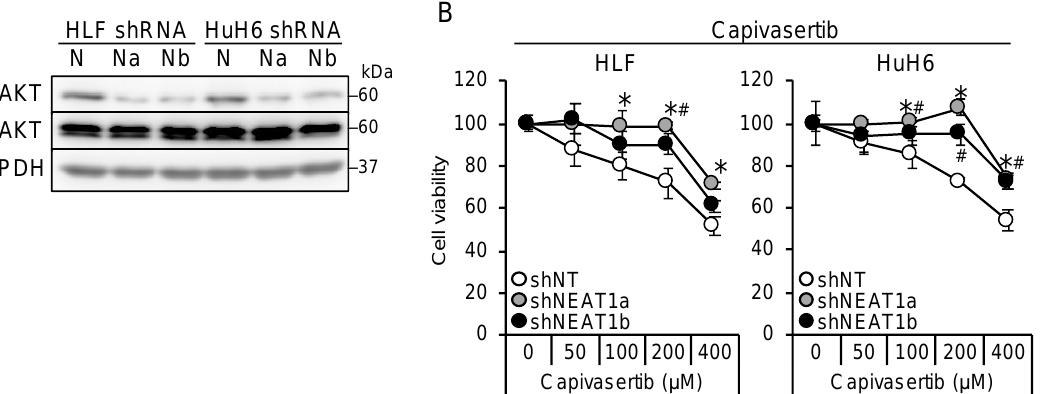
Figure 2. NEAT1 knockdown induces resistance against an AKT-targeted drug, capivasertib. ( A ) Representative Western blot images for the indicated proteins. GAPDH is shown as an internal control. HLF and HuH6 cell lines were transduced with adenoviruses expressing non-targeting shRNA [shNT (N)] or NEAT1-specific shRNAs [shNEAT1a (Na) and shNEAT1b (Nb)] for 48 h. ( B ) Viabilities of HLF and HuH6 cells treated with capivasertib at the concentrations indicated in the figure for 48 h relative to cells treated with DMSO (100%). Cells were transduced with adenoviruses ex- pressing shNT, shNEAT1a, and shNEAT1b 48 h before drug treatment. * p < 0.05 vs. shNT vs. shNEAT1a; # p < 0.05 shNT vs. shNEAT1b (Dunnett’s test; n = 4).